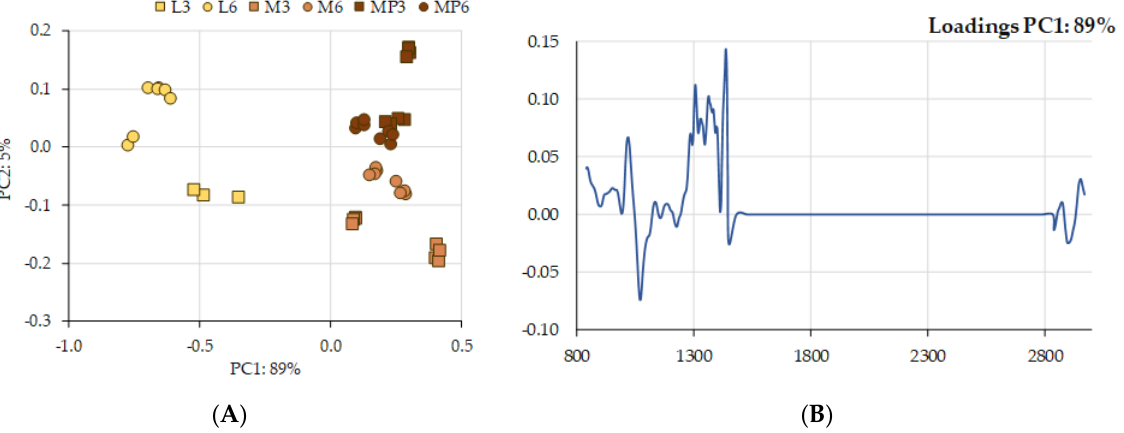
Figure 6. Score plot of two principal components from spectral data acquired with FTIT-ATR of AUS, concerning the toasting level of the wood used in the ageing process for three and 6 months. (A) — Score plot, (B) — loading plot.